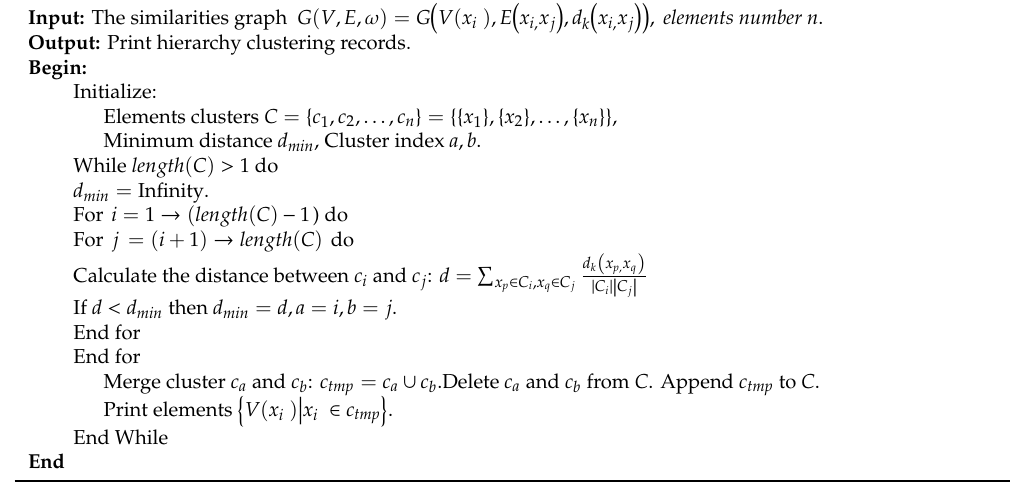
Table 9. Average-linkage algorithm for hierarchical clustering.